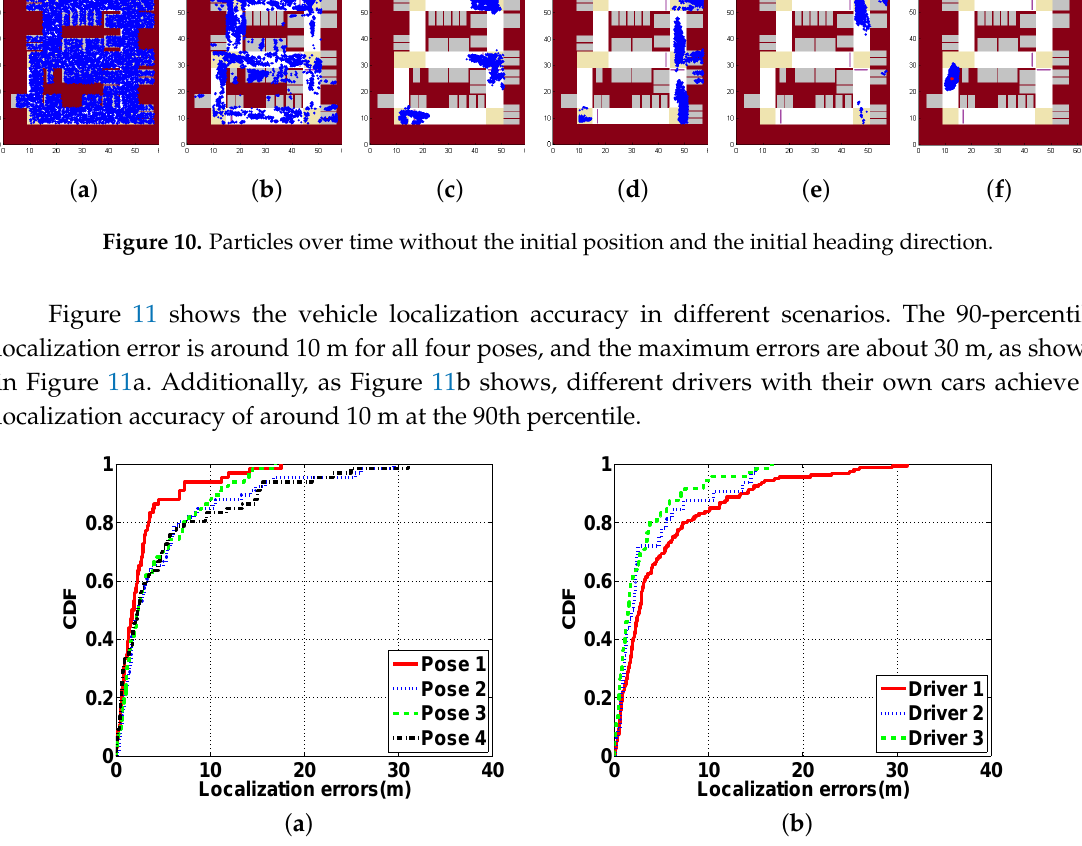
Figure 11. Vehicle localization errors in different scenarios: ( a ) four different poses; ( b ) three different cars and drivers in one parking